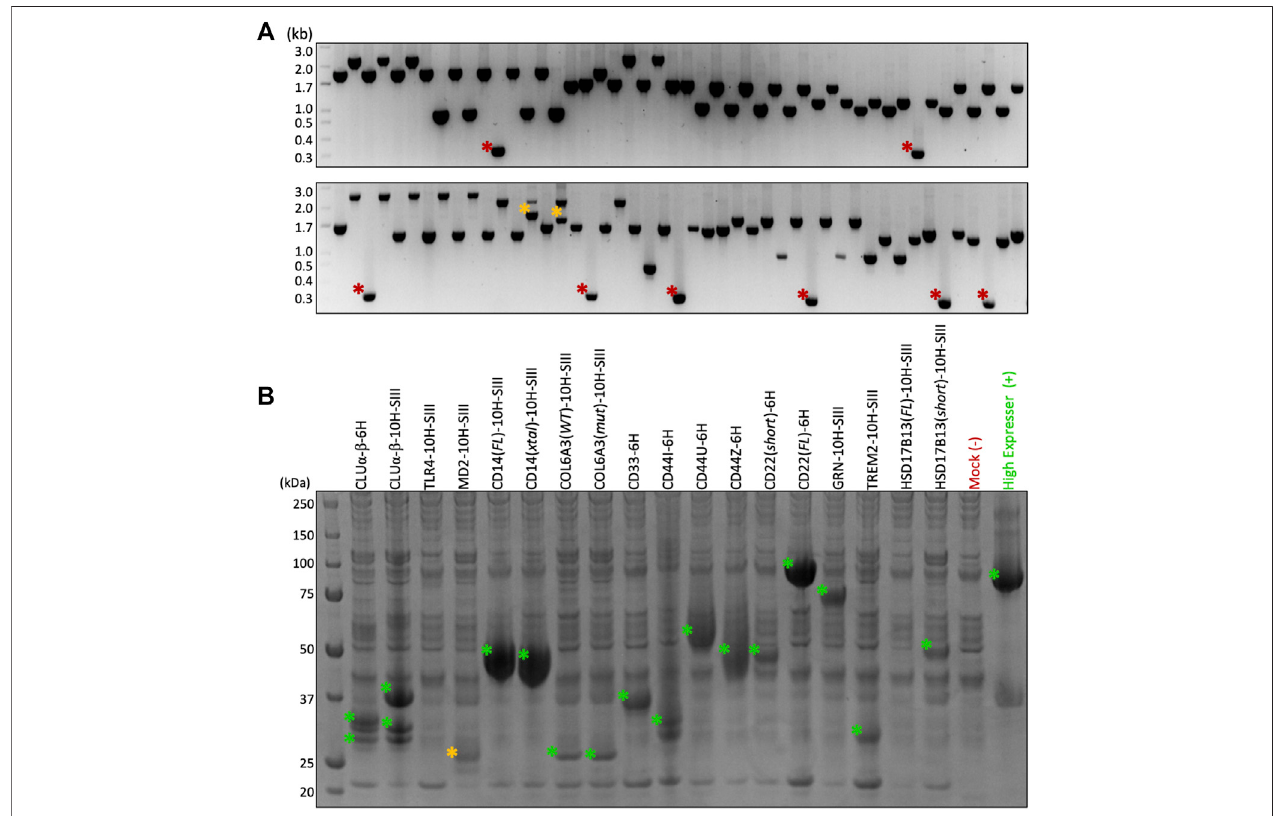
FIGURE 3 | Cloning and test expression results. (A) Colony PCR after selecting 94 colonies from 18 different constructs demonstrates > 90% assembly ef fi ciency using HiFi. Red asterisk = vector alone; orange asterisk = unidenti fi ed products. (B) SDS-PAGE after 3-ml test expression and Ni-NTA pull-down. Eighteen constructs and two controls tested in parallel. Green asterisk = target band con fi rmed by in-gel tryptic digest MSMS; orange asterisk = putative target